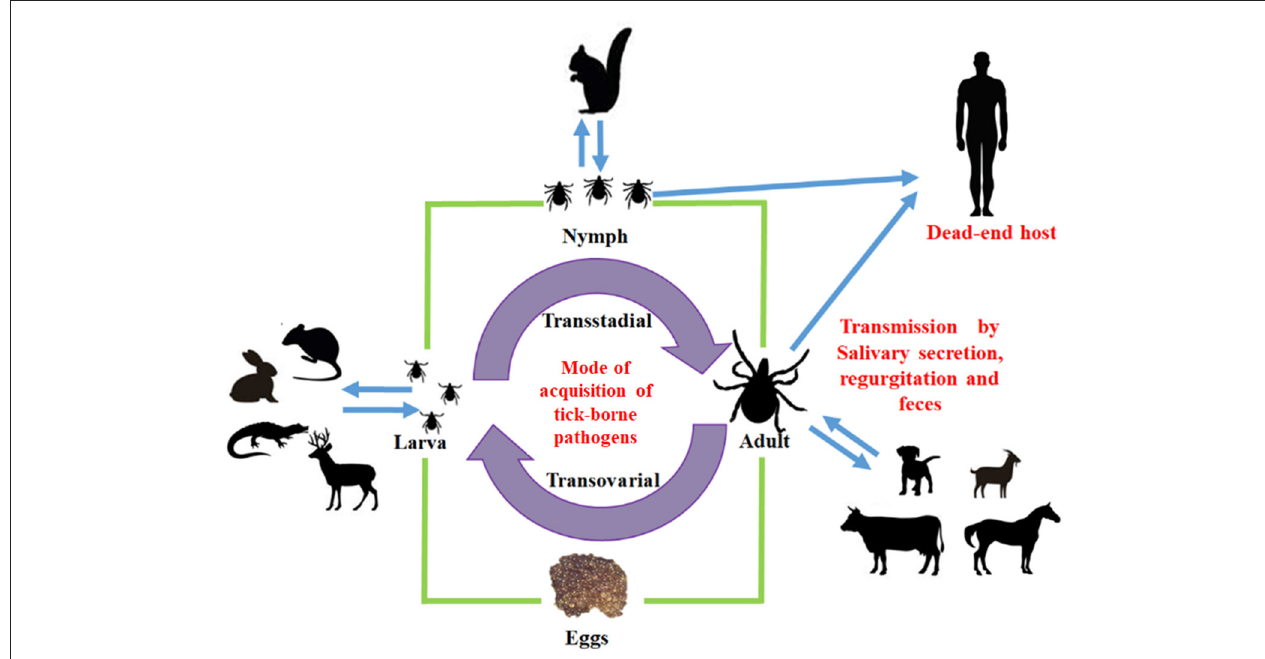
FIGURE 1 | Mode of acquisition of tick-borne pathogens. The different stages of tick (larva, nymph, and adult) may transmit bacteria to intermediate or final